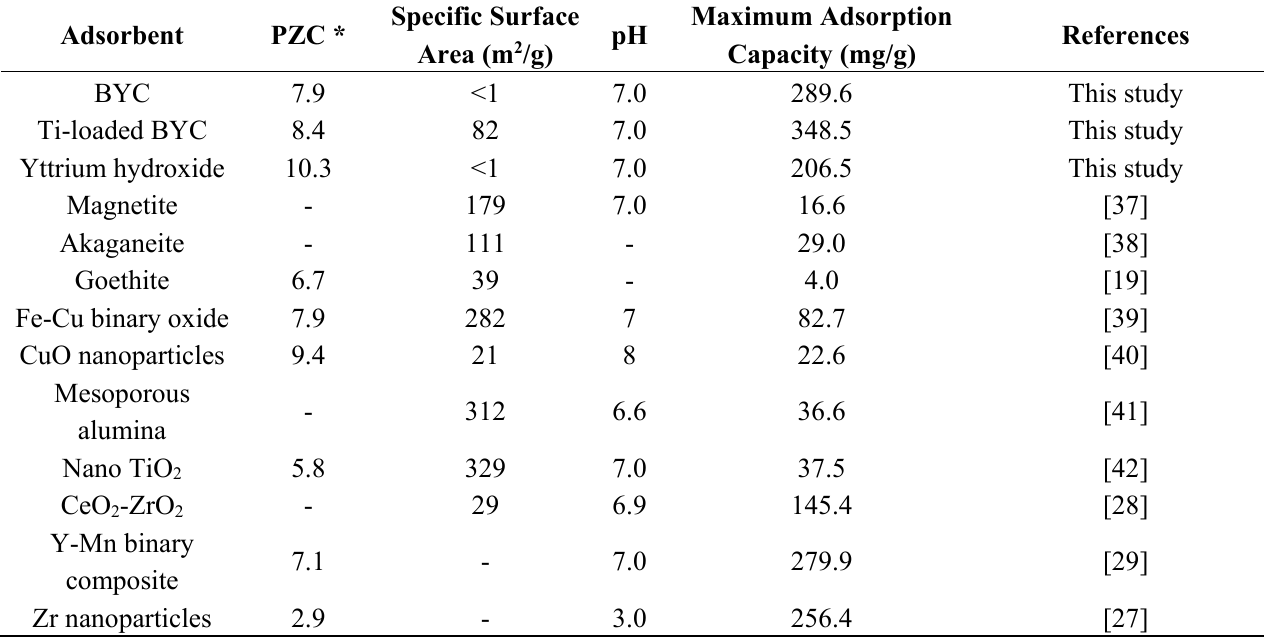
Table 1. Comparison of maximum adsorption capacities for arsenate and physical properties for different